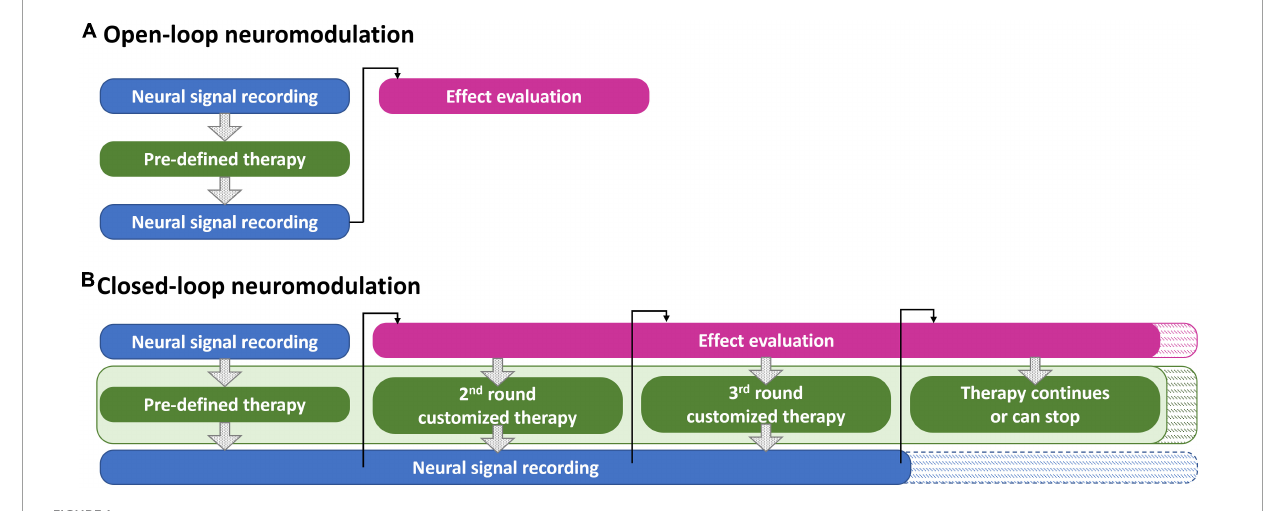
FIGURE1 The workflow examples of (A) an open-loop neuromodulation system and (B) a closed-loop neuromodulation system for METH addiction